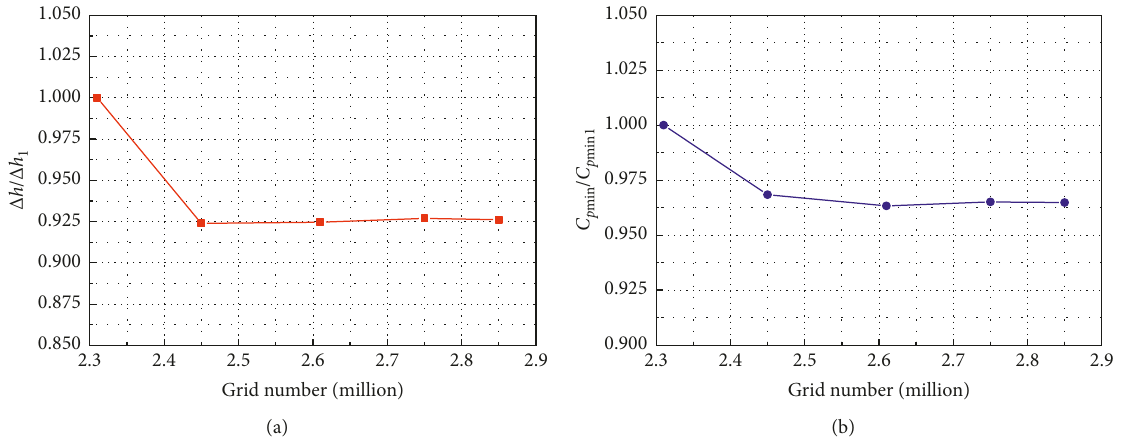
Figure 5: Grid sensitivity analysis. (a) Hydraulic loss. (b) Pressure coefficient C